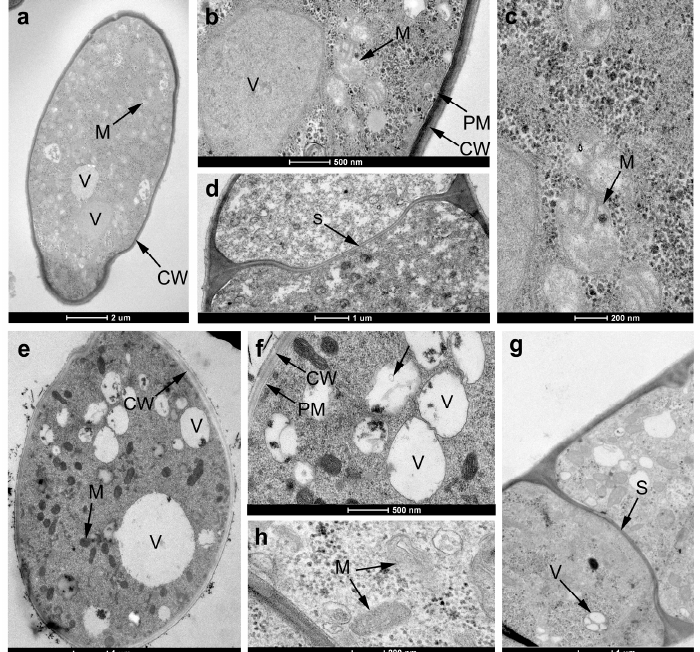
Figure 6. TEM of R. solani hyphae treated with 0 ( a – d ) or 50 μ g/mL 18 ( e – h ). ( a ) Transverse of control hyphae and many organelles were observed such as mitochondria (M) and vacuole (V); ( b ) cell wall (CW) and plasma membrane (PM) of untreated hyphae; ( c ) mitochondria of untreated hyphae; ( d ) longitudinal of untreated hyphae, and spectra (S) was uniform; ( e , f ) transverse of 18 -treated hyphae; ( g ) longitudinal of 18 -treated hyphae (loss of matrix in vacuoles and obvious vacuolization); ( h ) mitochondria of 18 -treated hyphae was